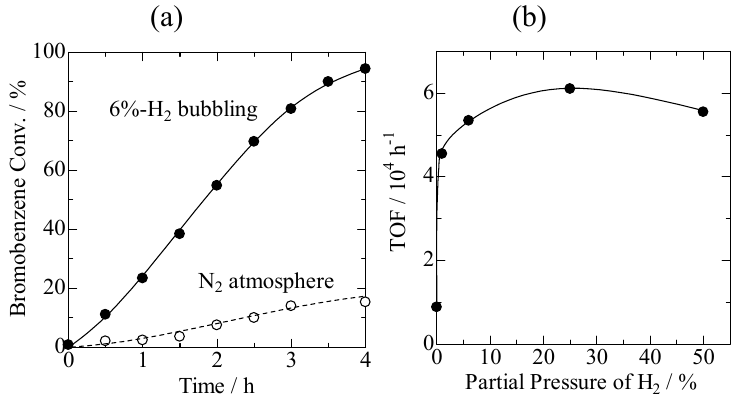
Figure 4. (a) Conversion of bromobenzene plotted as a function of the reaction time; (b) Turnover frequencies plotted as a function of partial pressure of H between bromobenzene and styrene over 0.4 wt %-Pd/USY. USY was prepared by steaming of NH -Y at 873 4